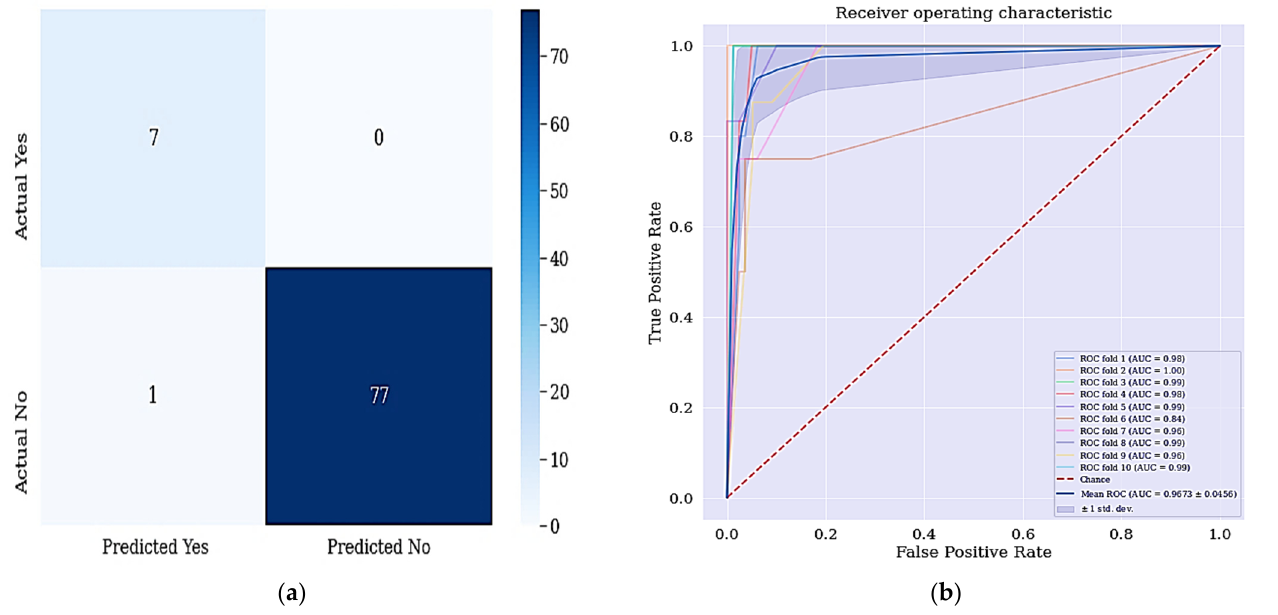
Figure 7. ( a ) Confusion matrix for DT + RFE + SMOTETomek and ( b ) ROC Curve for DT + RFE + SMOTETomek techniques. Figure 6a shows the confusion matrix of DT + RFE + SMOTETomek and its resulting AUC. Table 7. Comparison of biopsy test results of our model with past